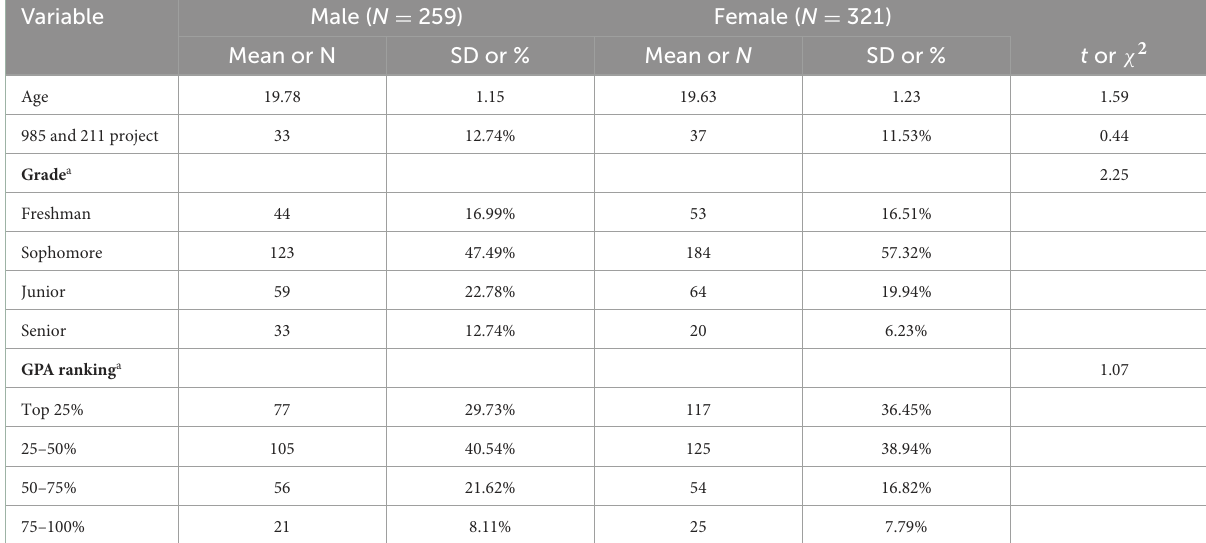
TABLE 1 Demographic and academic characteristics grouped by